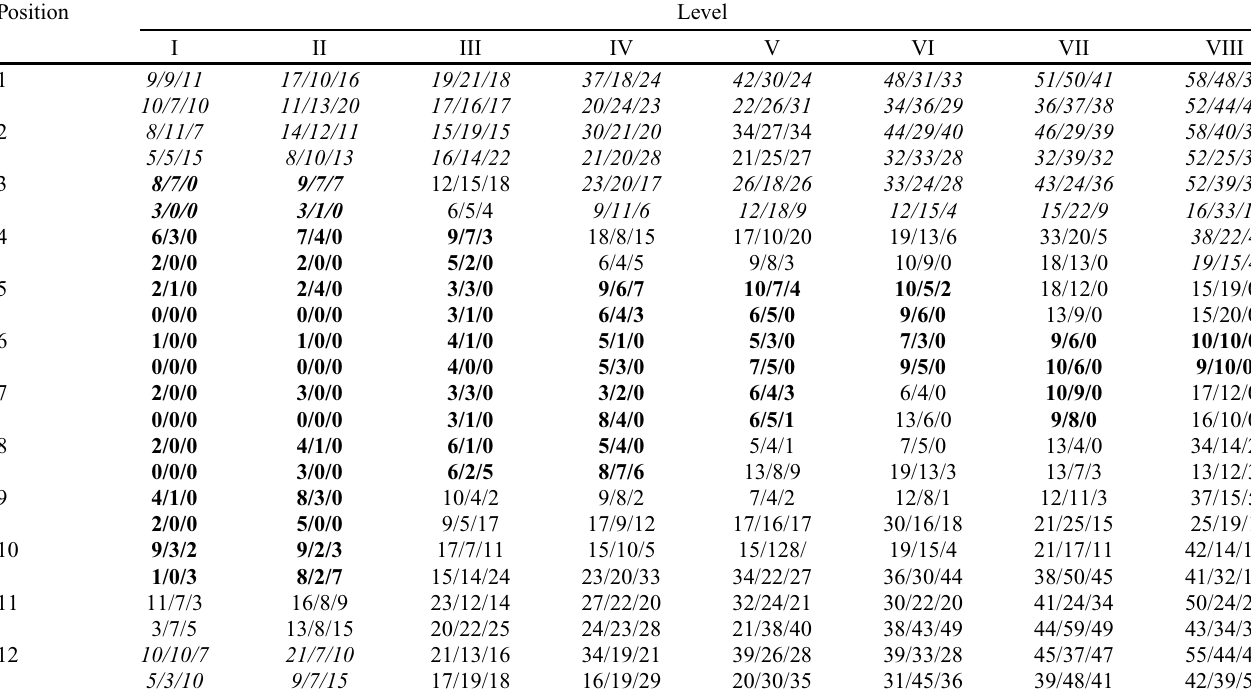
Table 1. Displacement of skin/fascia/muscles [mm] relative to the ulna at 70 (cid:2) of pronation and 70 (cid:2) of supination.